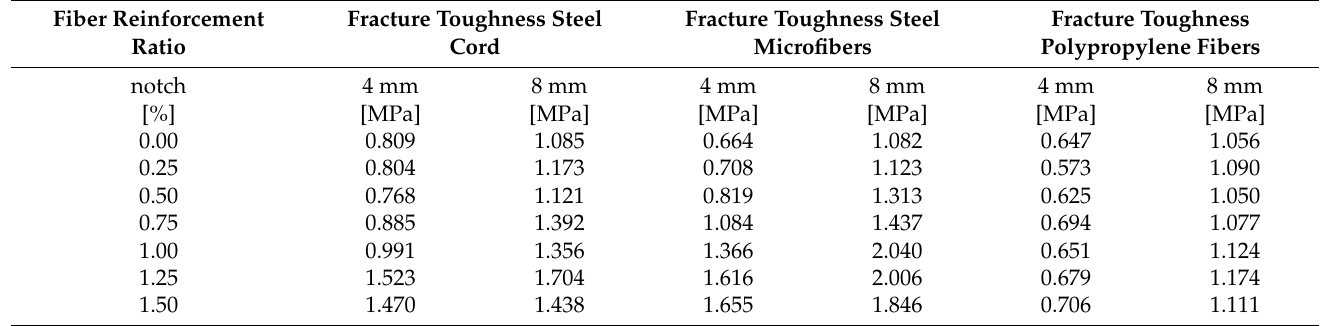
8 mm. Table 5. Fracture